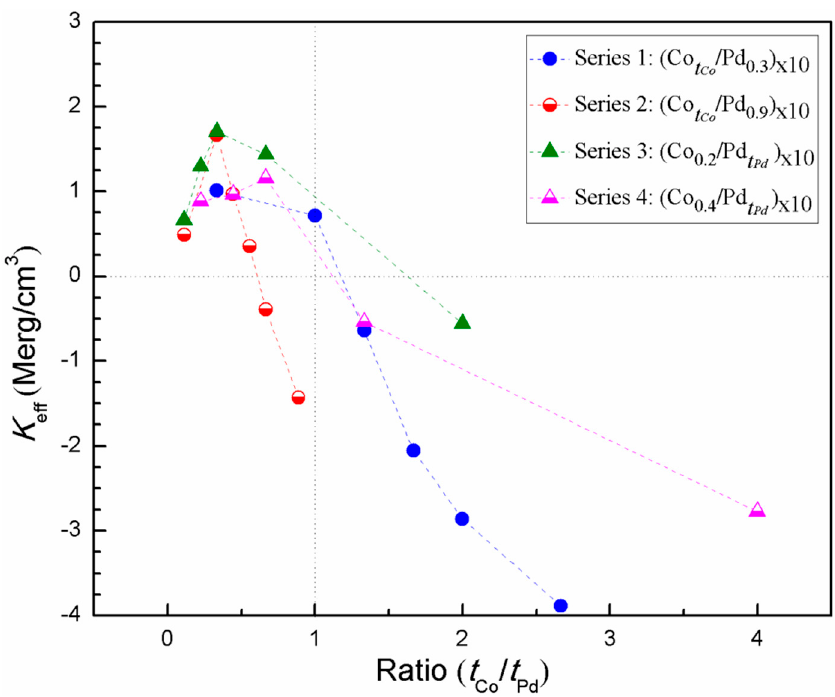
Figure 11. Plot of effective anisotropy of the entire sample series as a function of the ratio of Co and Pd thickness ( t Co / t Pd